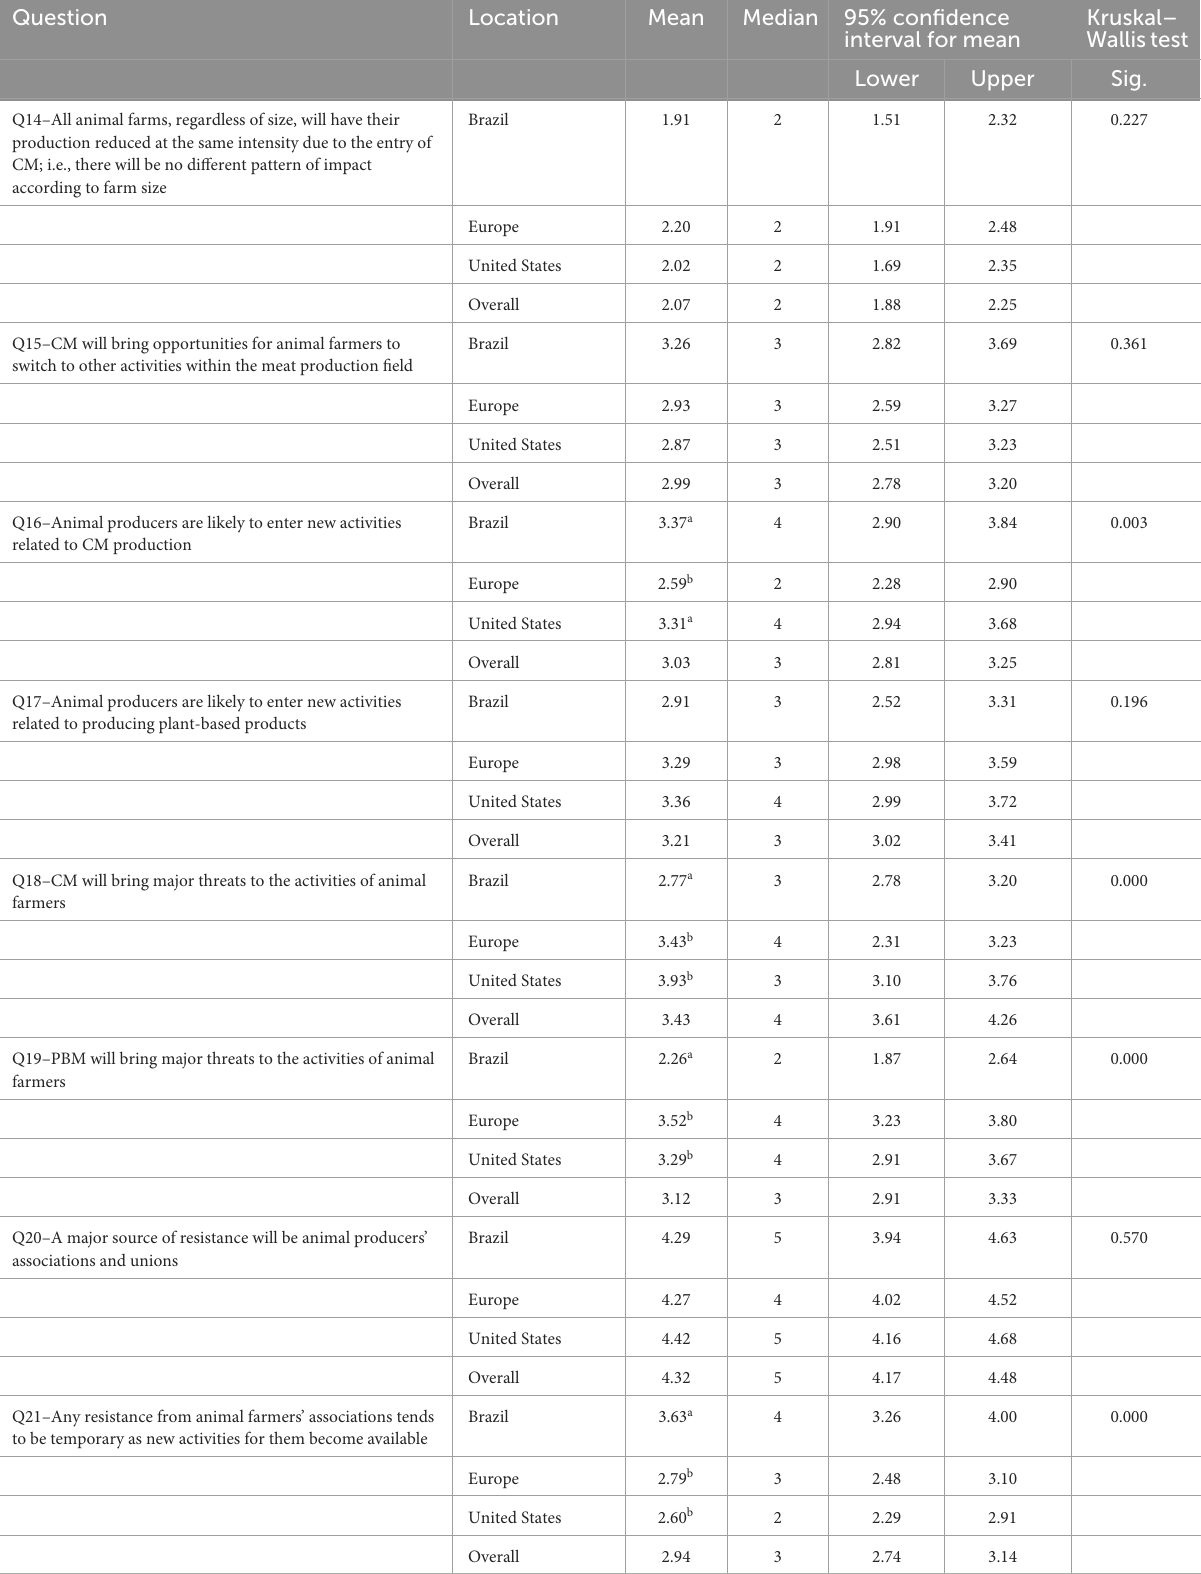
TABLE 5 Analysis for Q14–Q21 regarding impact on farms in Brazil ( N = 35), Europe ( N = 56), and the United States ( N = 45) using Likert scale from 1 (strongly disagree) to 5 (strongly agree), as per interviews from August to October, 2021. Question Location Mean Median 95% confidence